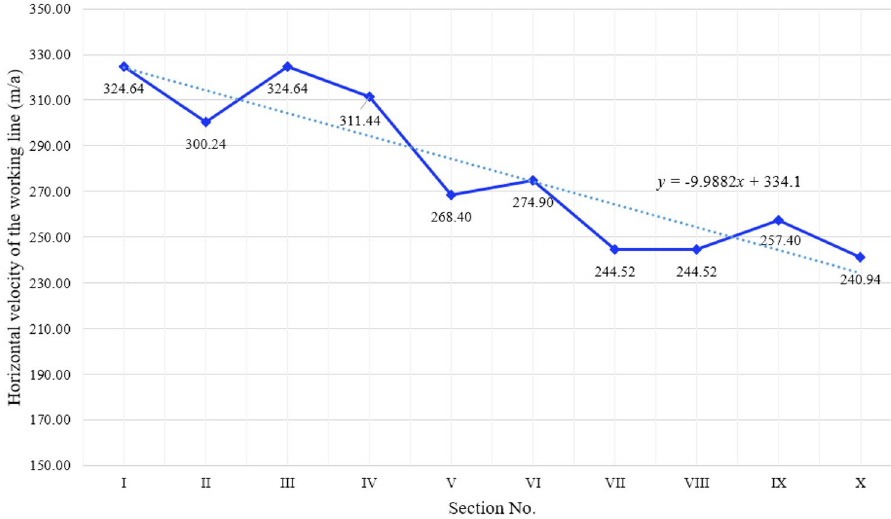
Fig. 16 Linear fitting of horizontal advancing speed of working line in pseudo-longi- tudinal mining scheme